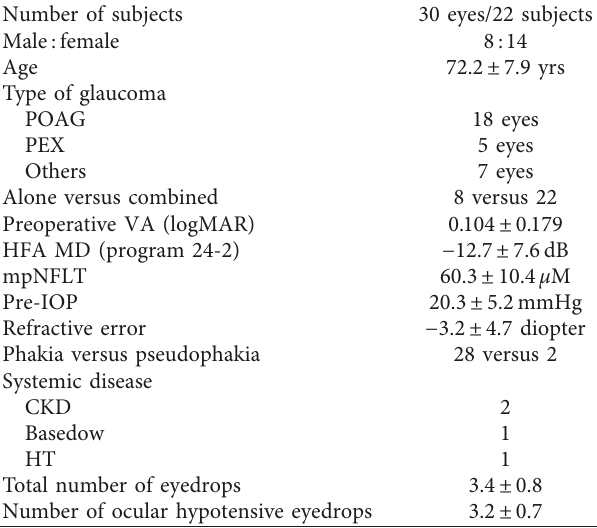
Table 2: Comparison between preoperative and postoperative